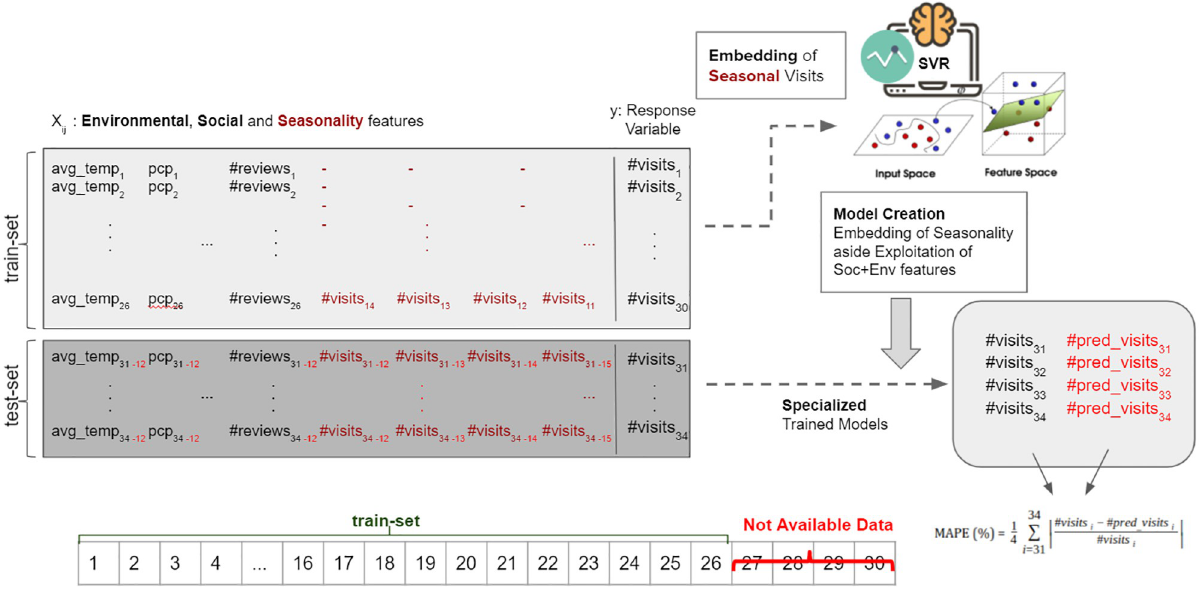
Fig 5. Tourism demand prediction methodology in scarcity of recent data adopting social media, environmental and seasonality features.